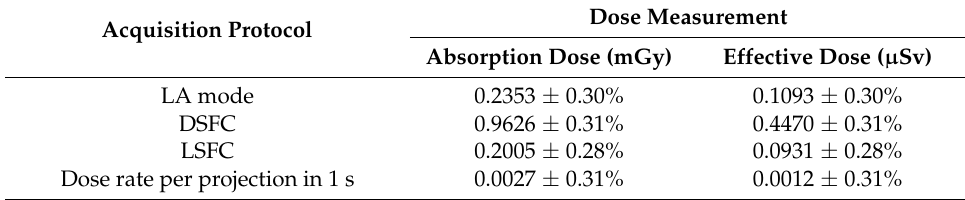
Table 5. Average absorption dose and dose equivalent from 10 measurements for three protocols: LA, DSFC and LSFC